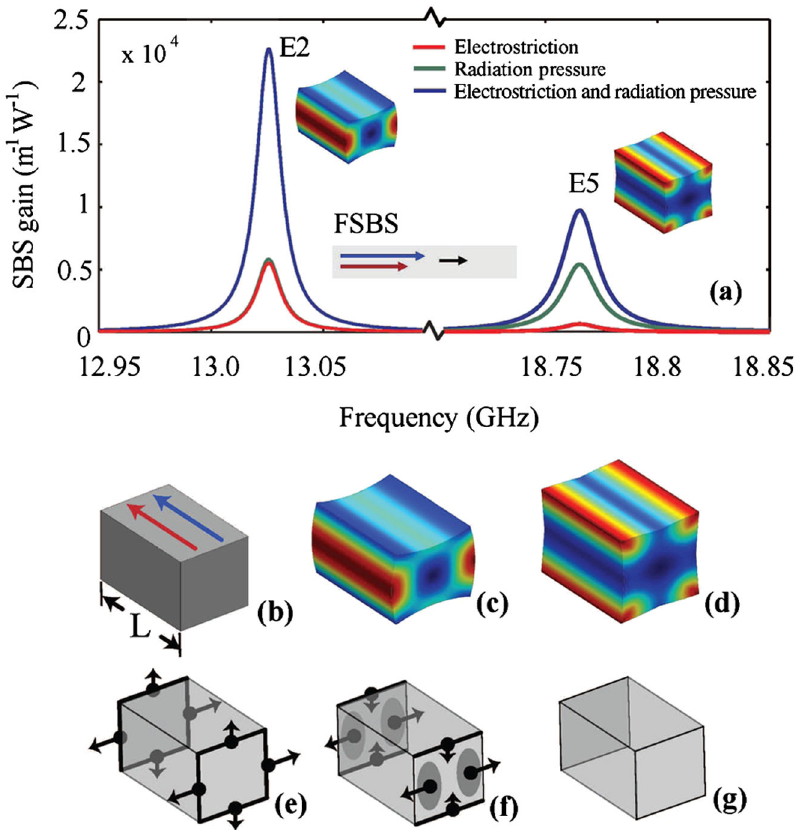
FIG. 3. Detailed analysis of FSBS: (a) The computed FSBS gain vs the phonon frequency near the E2 and E5 resonances centered at 13.0 and 18.8 GHz. The individual contributions of electrostriction (red) and radiation pressure (green) to the SBS gain are shown along with their combined effect (blue). Simulations assume a phononic loss Q of 1000 and optical wavelength (cid:2) ¼ 1 : 55 (cid:1) ms . (b) A schematic of a waveguide segment ( L ¼ 300 nm ). (c) and (d) are the characteristic displacements of the E2 and E5 elastic modes. High-displacement regions are shown in red, and low-displacement regions are shown in blue. Schematics showing the amplitudes and directions of the dominant components of ~ f (cid:1) ð x ; y Þ are seen in (e), (f), and (g). Radiation pressure contributes only to the transverse force components (e), while electrostriction contributes to both the transverse components (f) and the longitudinal components (g). Note that the longitudinal forces are vanishingly small for